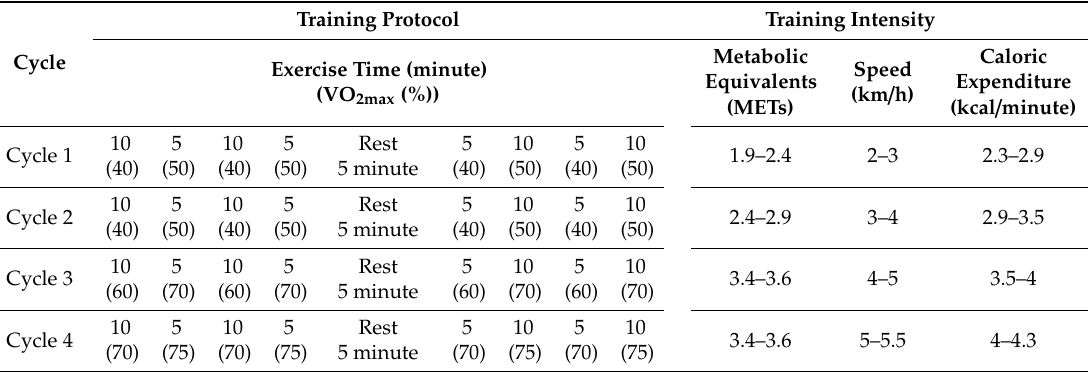
Table 1. Exercise protocol (horizontal walking). Session type (three per week) for each training cycle (4 months). VO 2max : maximum oxygen